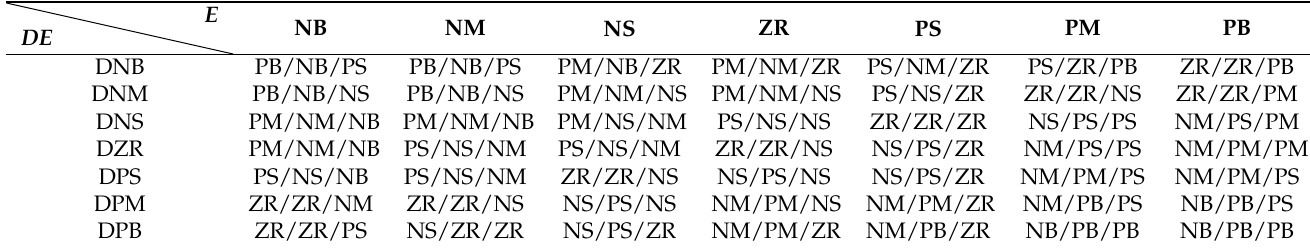
Table 3. ∆ K p / ∆ K i / ∆ K d fuzzy control